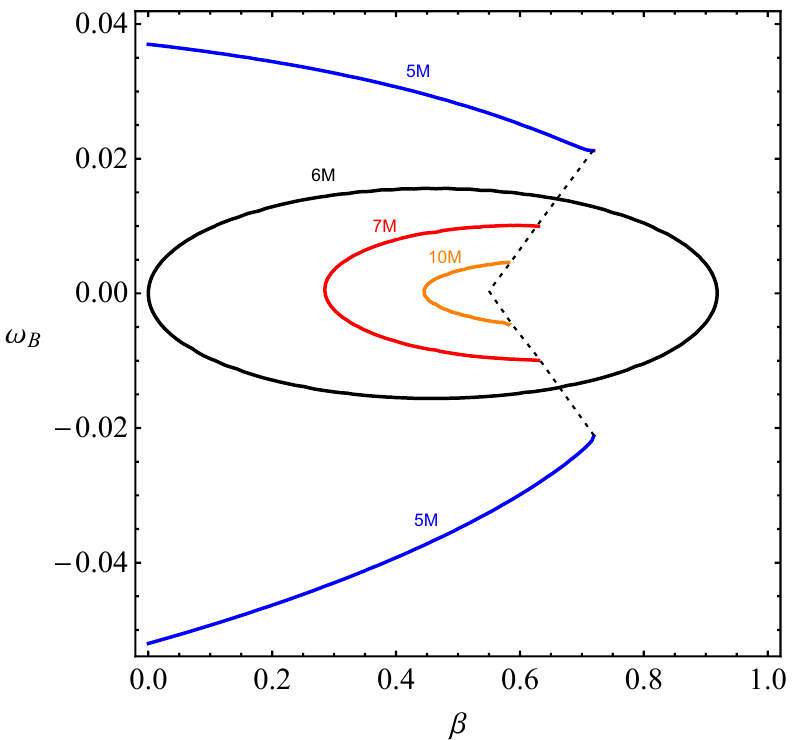
Figure 4. Possible values of parameters ω B and β for a ISCO radius between 5 and 10